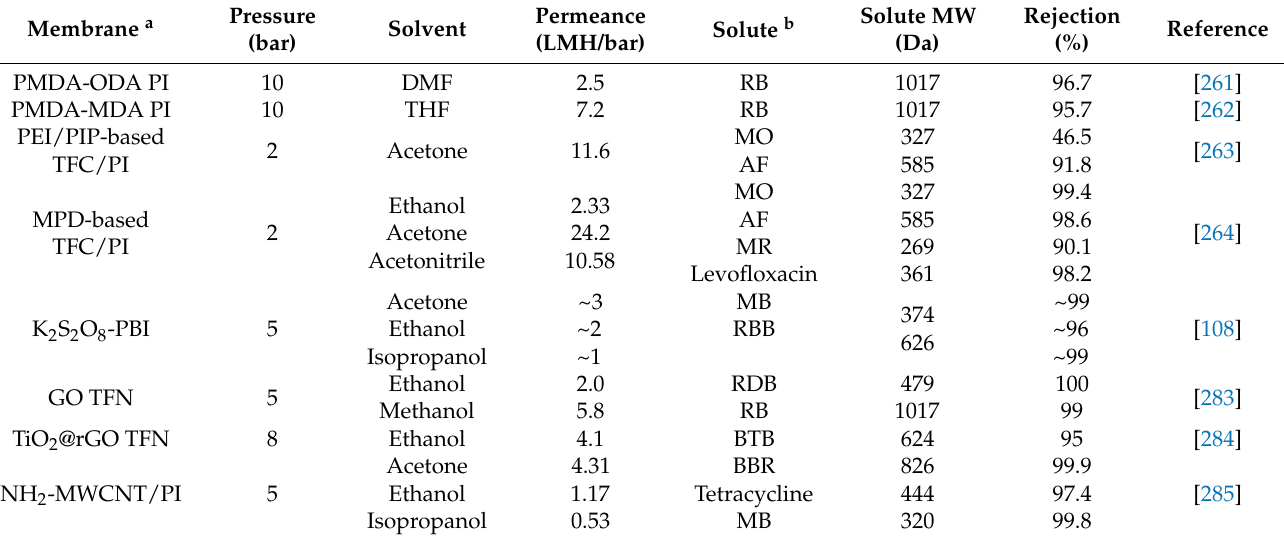
Table 2. OSN performances for hollow fiber